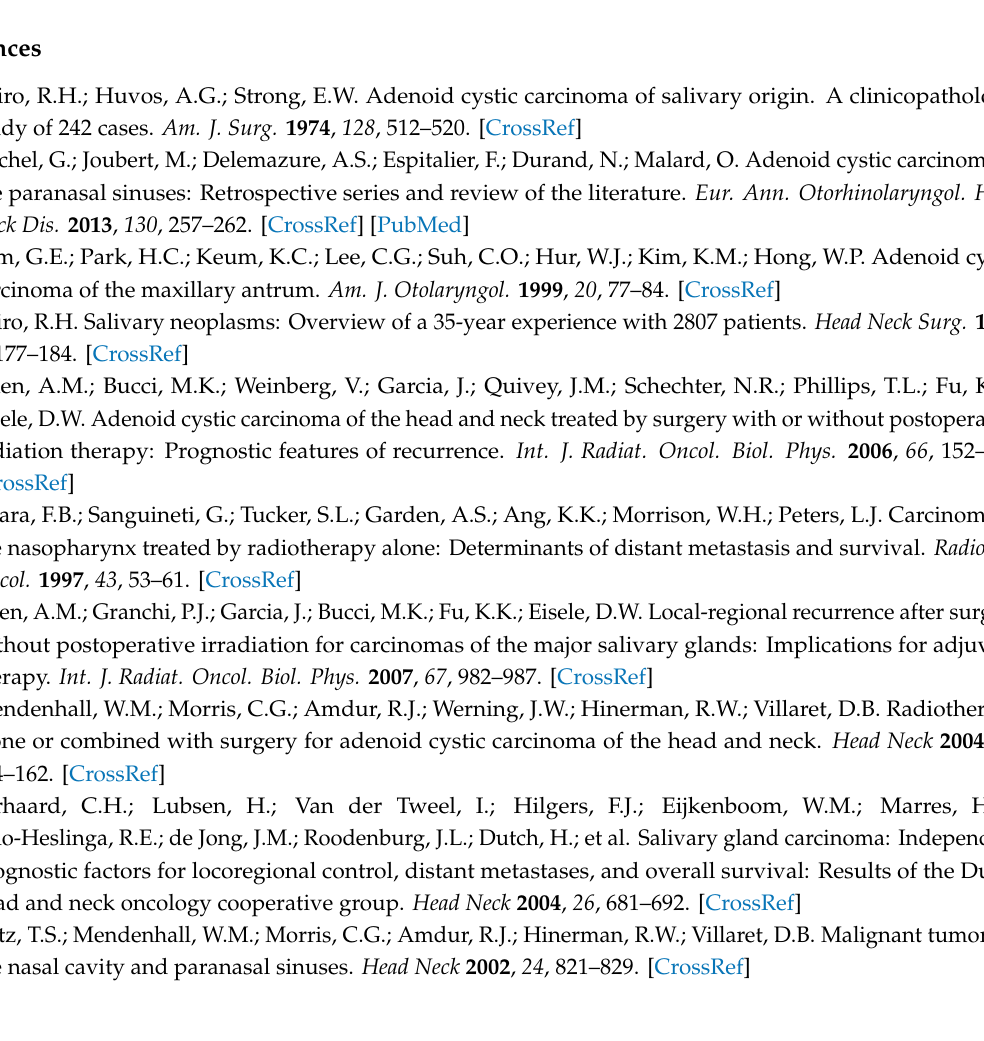
Figure S1: Distribution of the risk factors age., Figure S2. Venn diagram showing the distribution and the overlap of local recurrences., Table S1: RECIST analysis of 227 patients at di ff erent time points over follow-up., Table S2: Univariate analysis for local control., Table S3: Analysis of the recurrence patterns at last follow-up., Table S4: Overview of acute and late toxicity over